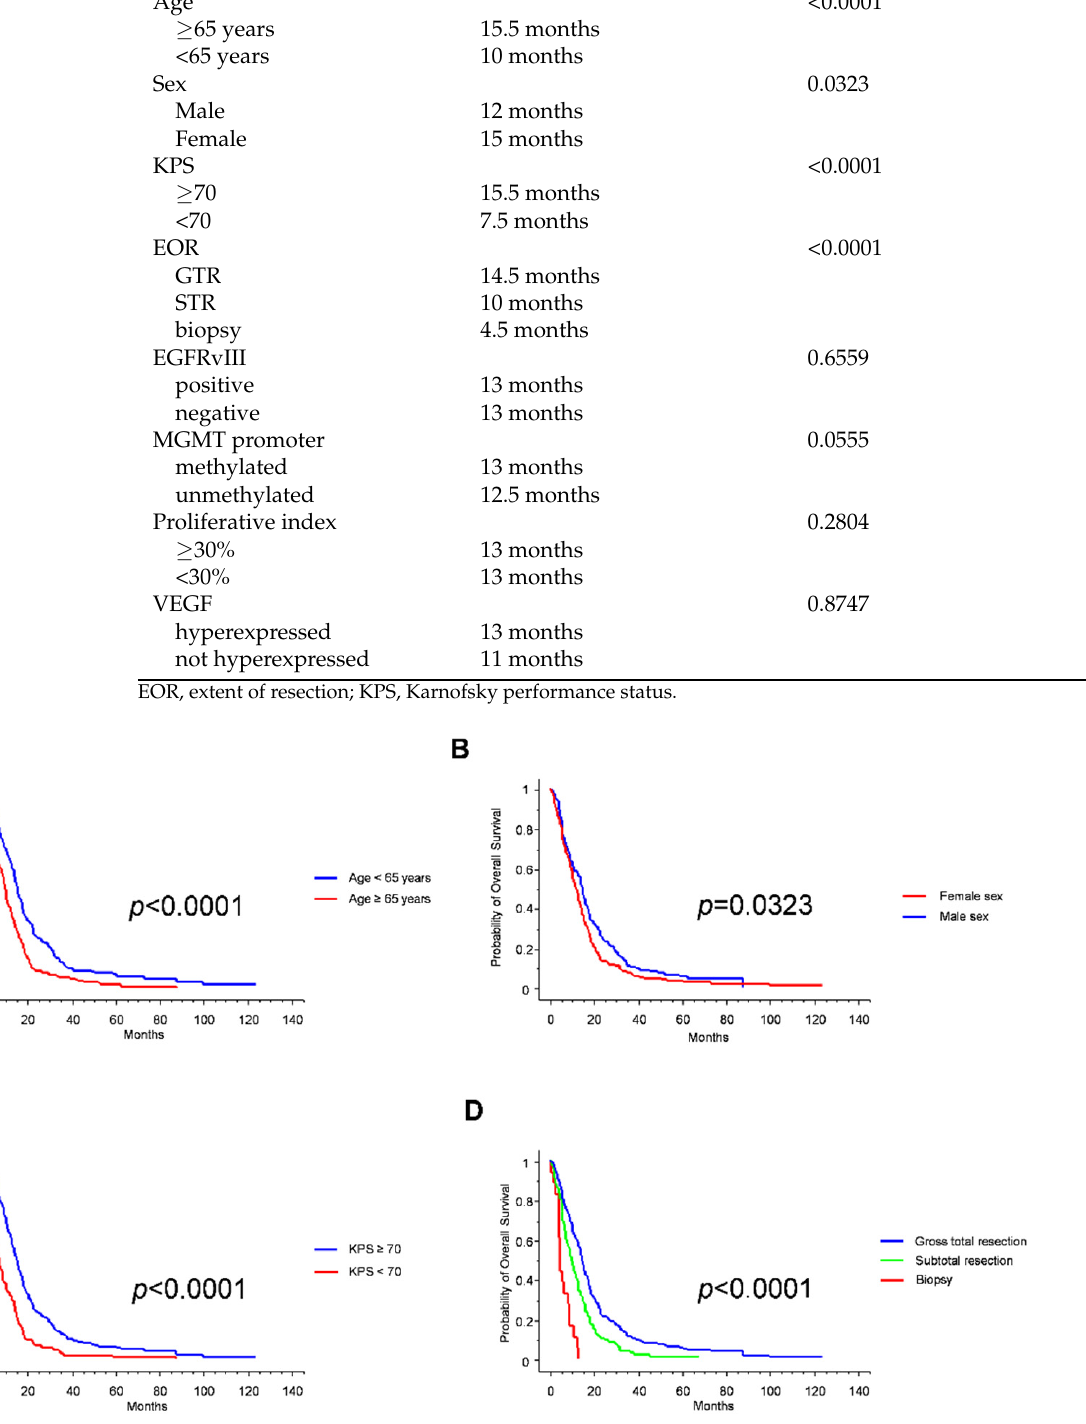
Figure 1. Kaplan–Meier survival curves for age ( A ), sex ( B ), Karnofsky performance status ( C ) and extent of resection ( D ).